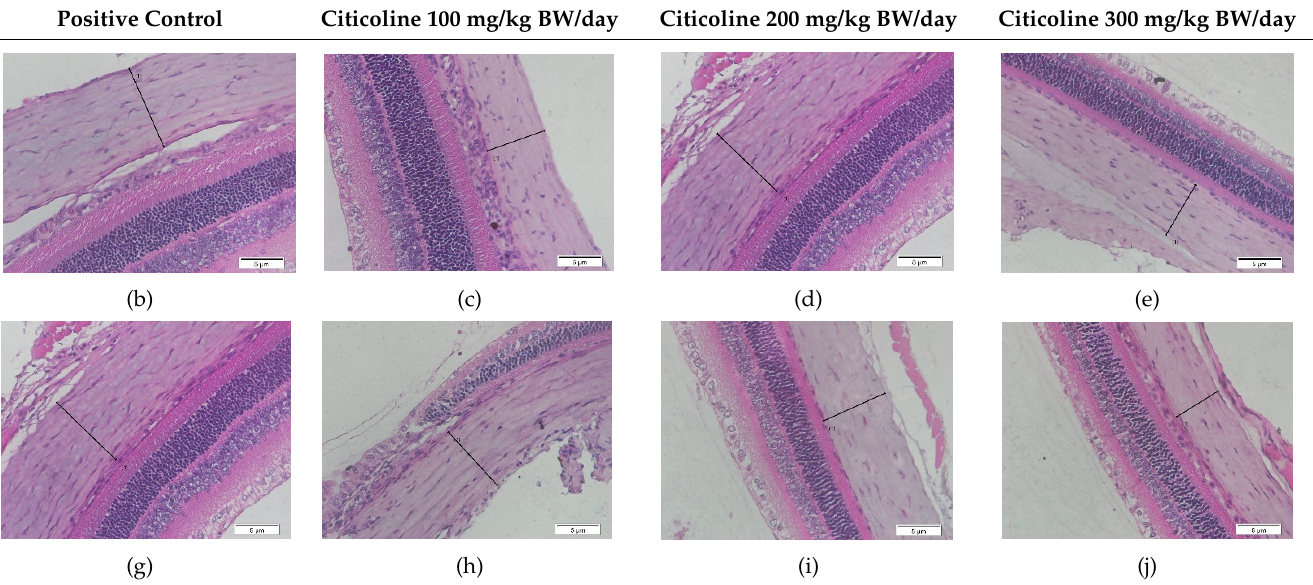
Table 1. Measurements of the rats’ scleral tissue thicknesses using HE-staining method.